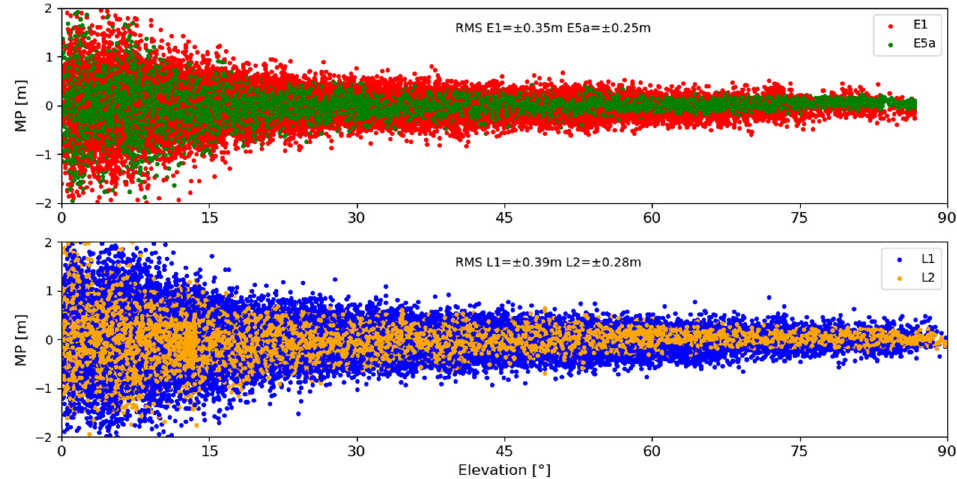
Figure 3. Multipath code combination (MP) for the E1 and E5a observations for the Galileo and L1 and L2 observations for the GPS for the MAS100ESP station for the 39 DoY with function of elevation angle.